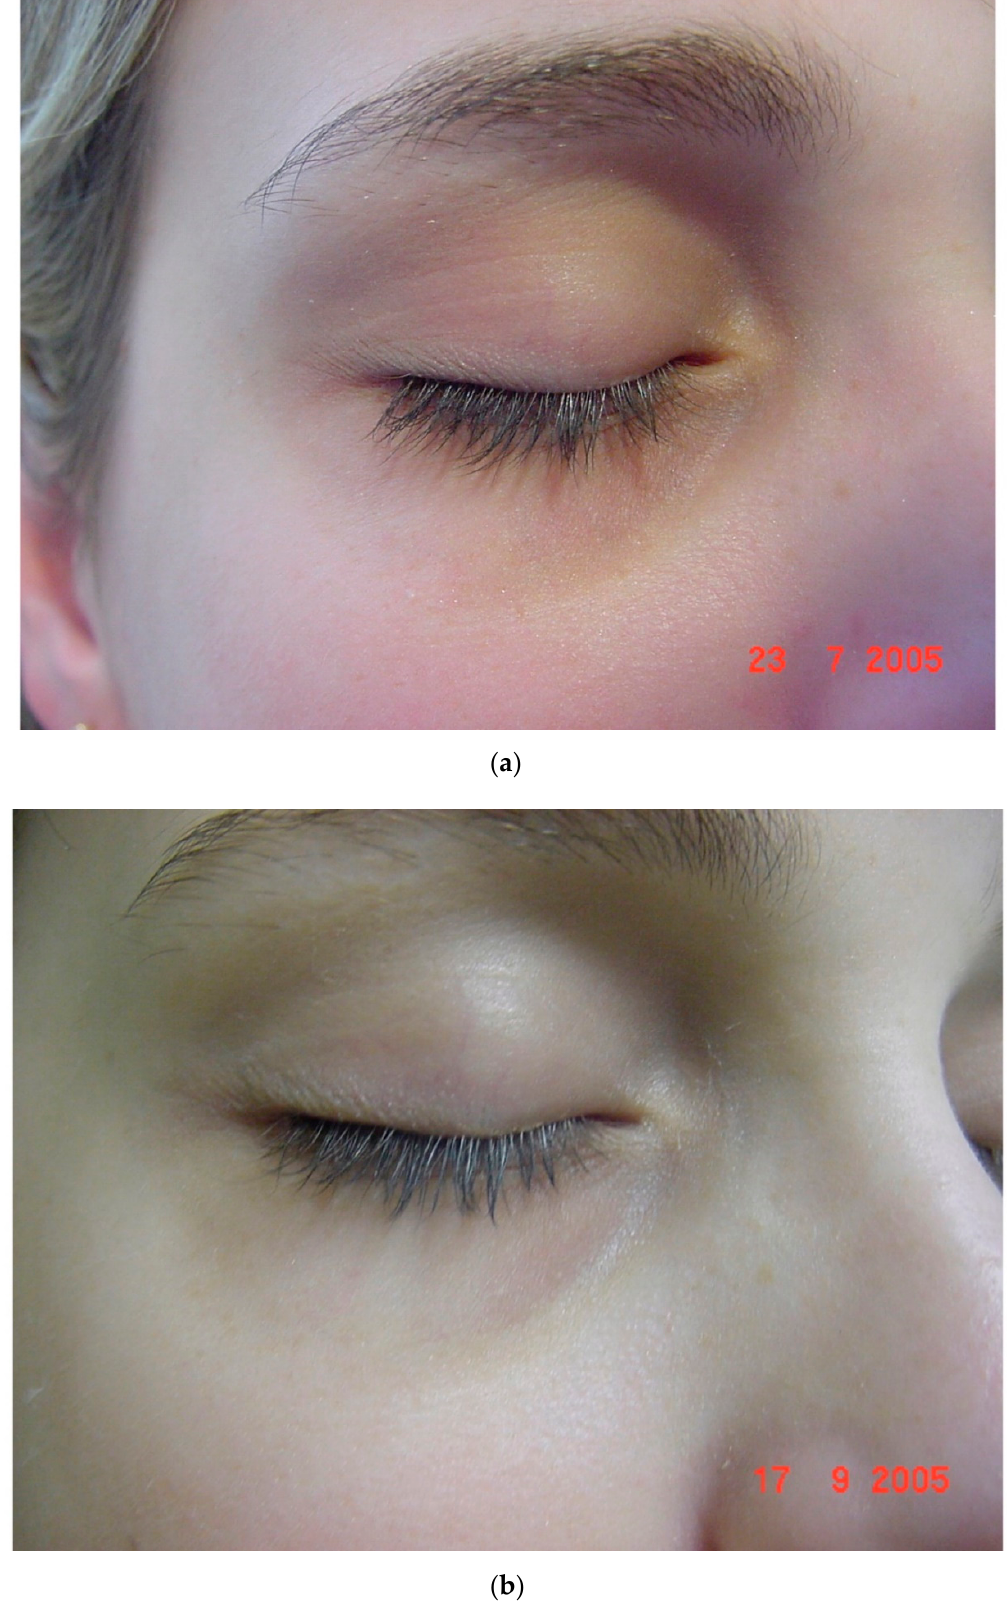
Figure 3. ( a )—19-year-old patient. Chronic treatment of asthma. Hyperpigmentation in upper and lower eyelids. ( b )— Result after two sessions of 1064 nm Q-Switched Nd-YAG laser and one session of long pulsed 1064 nm Nd-YAG laser.